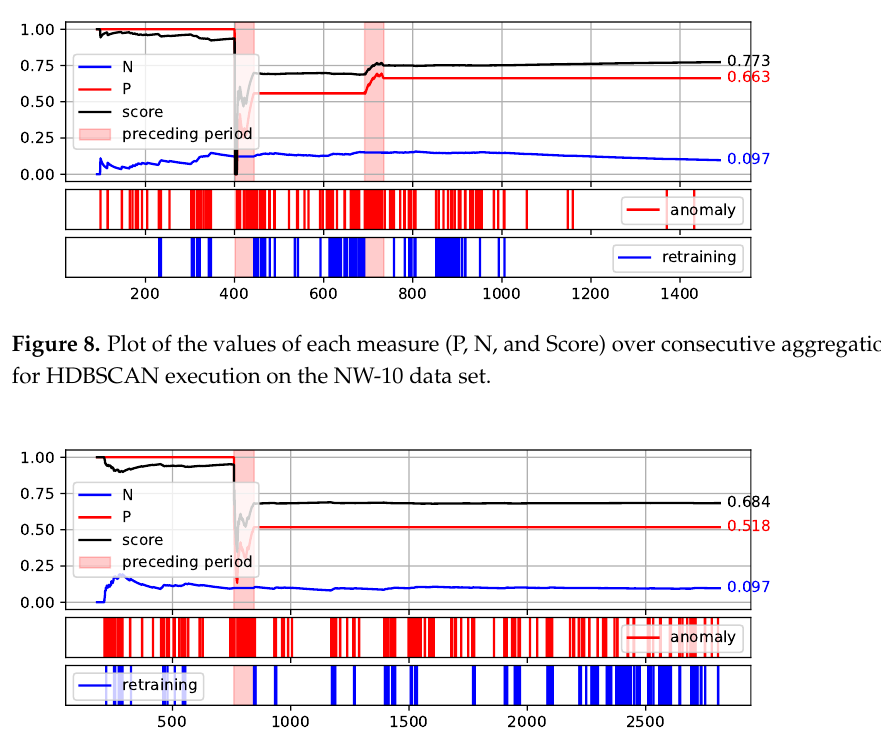
Figure 9. Plot of the values of each measure (P, N, and Score) over consecutive aggregation windows for HDBSCAN execution on the NW-20 data set.